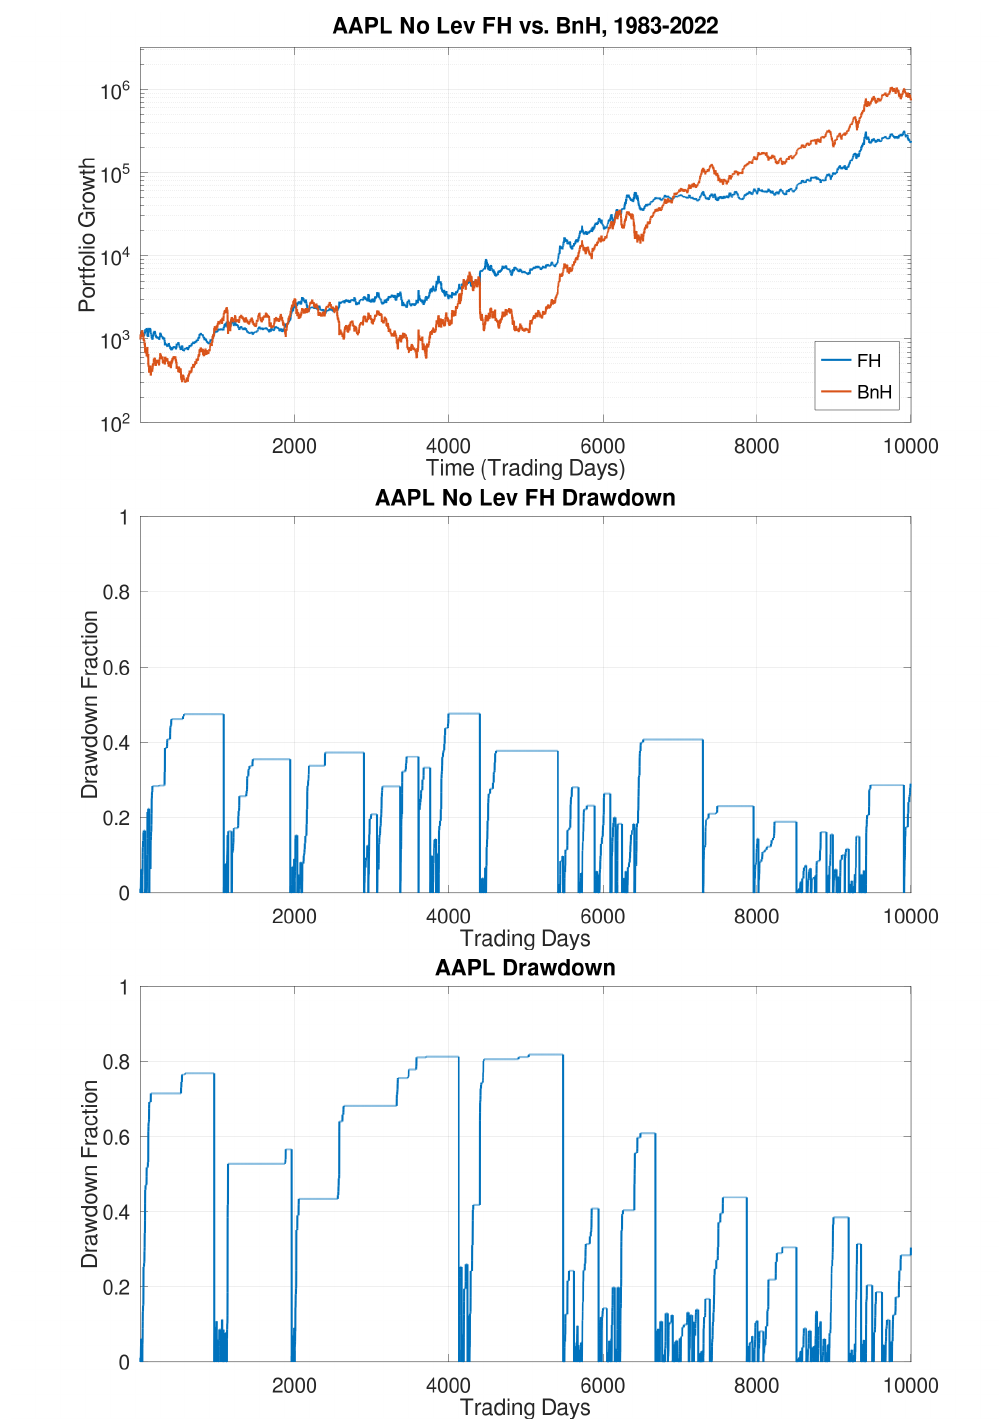
Figure 11. ( top ) The performance of a FastHedge algorithm for trading AAPL stock over a 40-year period ending 31 December 2022, compared to BnH. ( middle ) An indication of the drawdowns for the FastHedge algorithm over the 40-year period, and ( bottom ) of the BnH algorithm with AAPL stock, with unacceptably high losses above